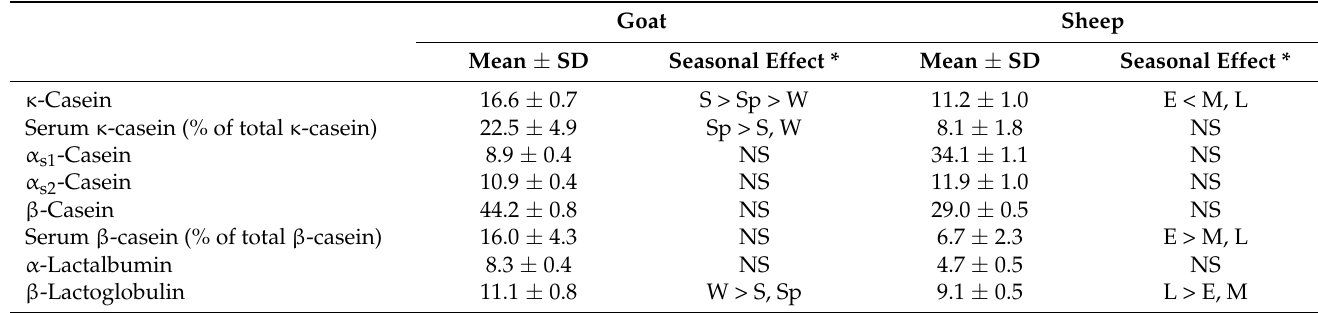
Table 3. Protein compositions of goat and sheep milks (indicated by the percentage of HPLC peak area of individual proteins in all identified